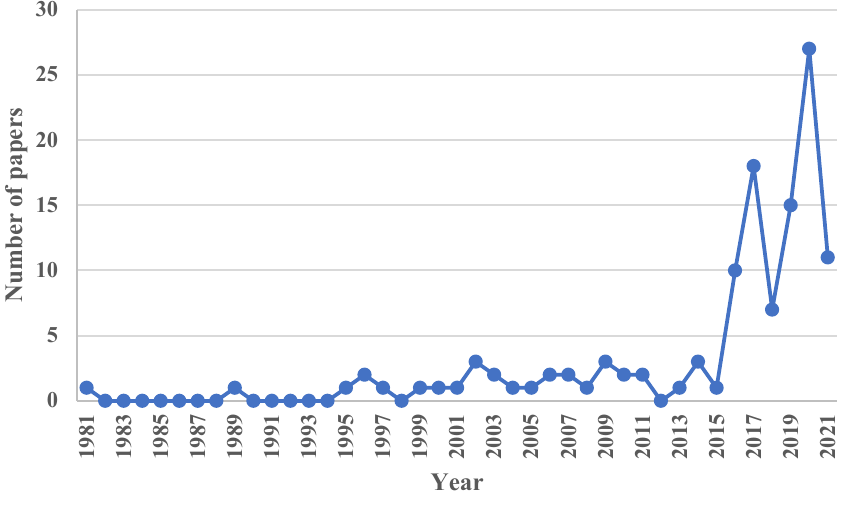
Figure 2. Number of papers.